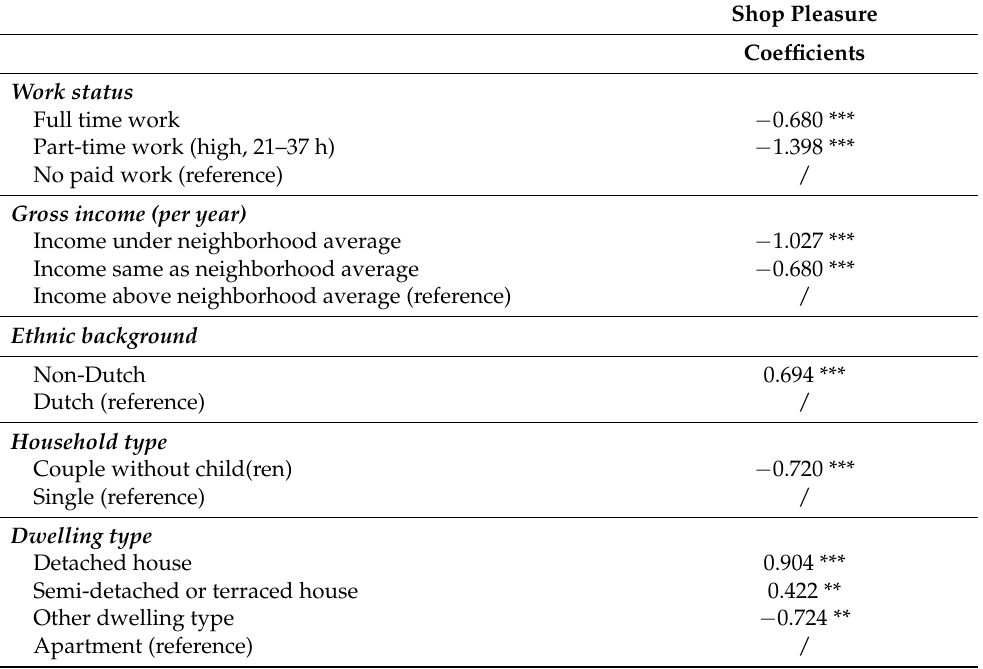
Table 5. Results of the MNL models ( happiness sense